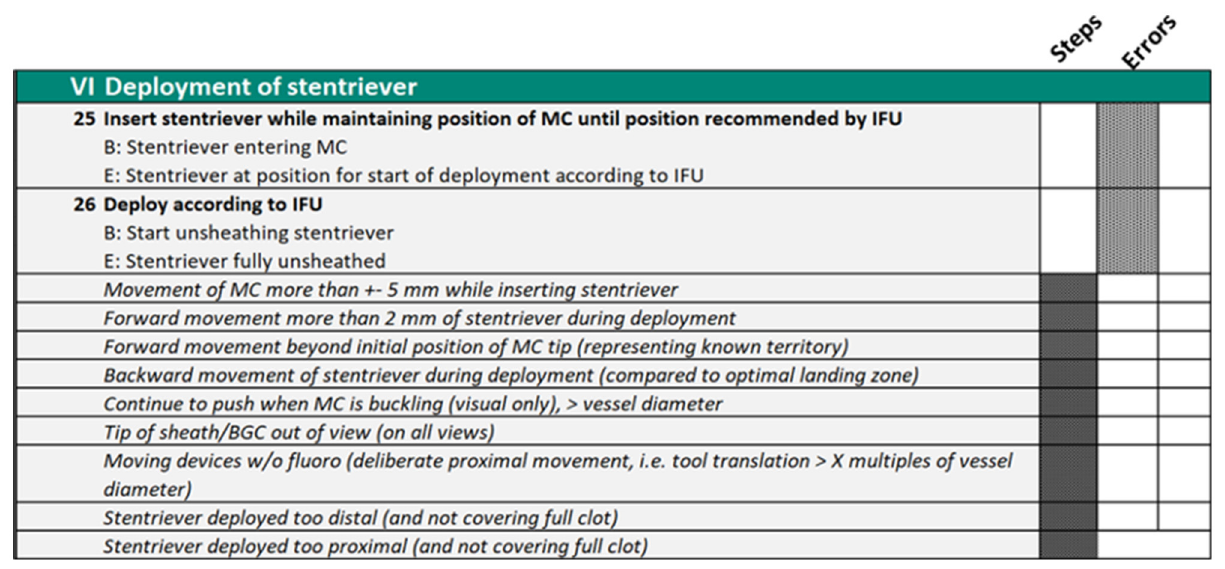
FIGURE 2 | Phase VI of the procedure metrics which explicitly define what the operator must do to complete the procedure and the errors they should